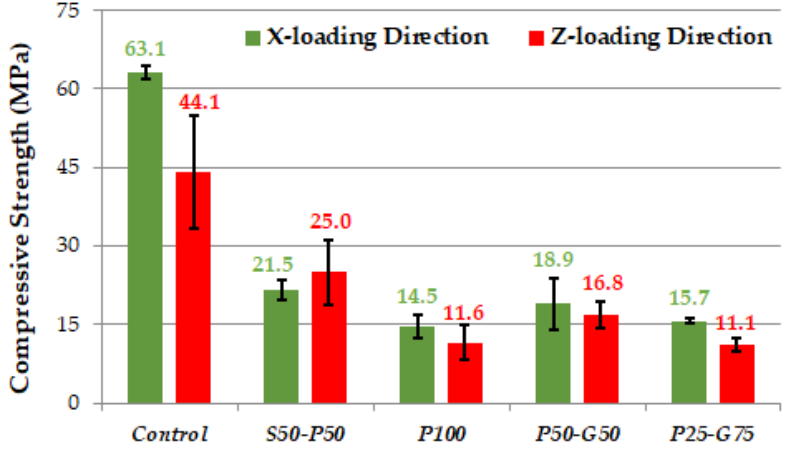
Figure 12. Compressive strength of both the control and rubber-cement samples tested in two loading directions.